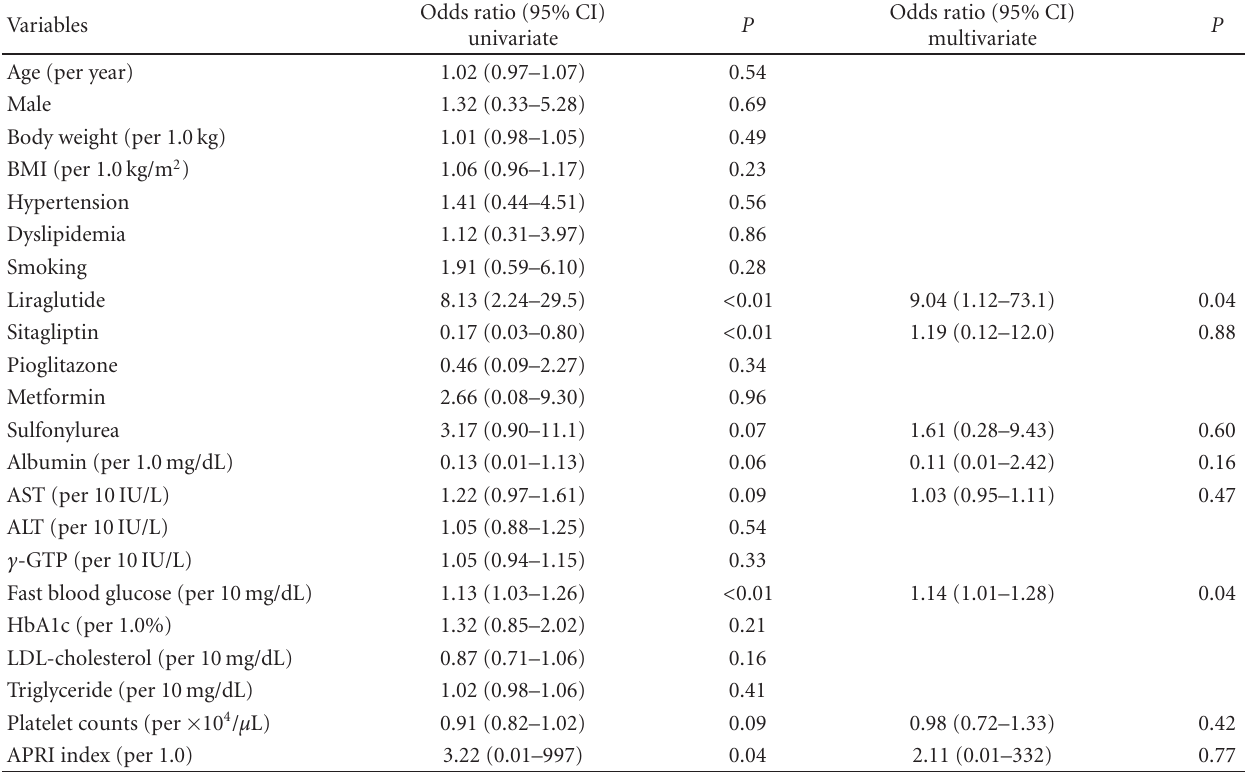
Table 5: Univariate and multivariate logistic regression analysis to evaluate the factors which contribute to body weight reduction for over